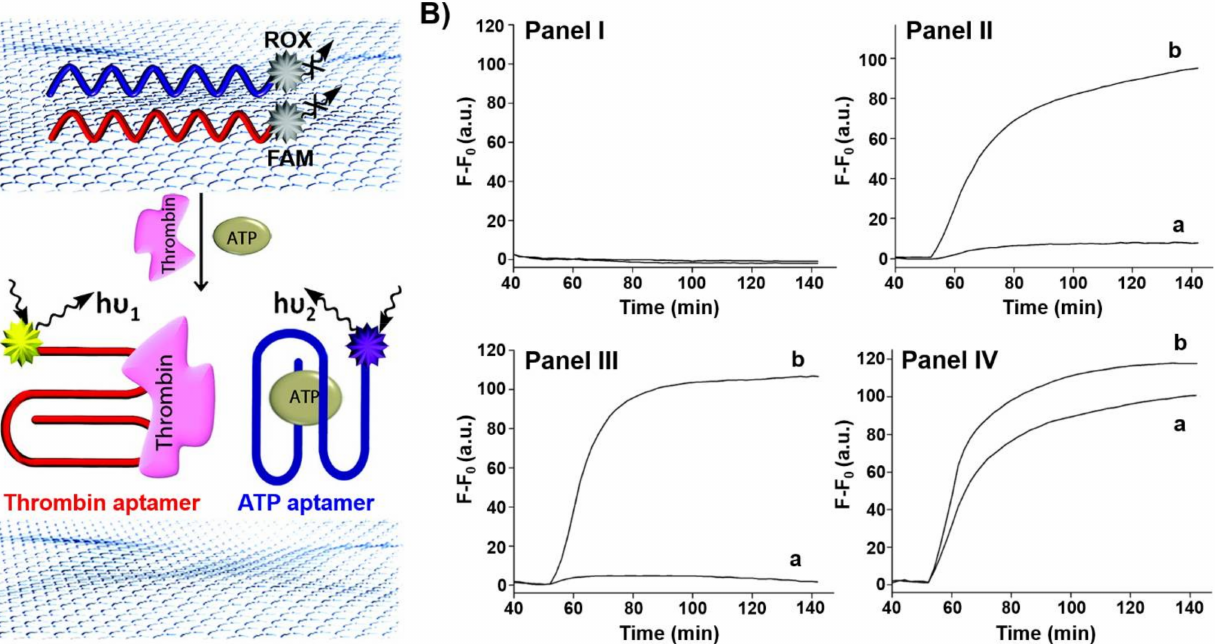
Figure 1. ( A ) Multiplex analysis of two ligands (thrombin, ATP) by 6-carboxyfluorescein (FAM)-functionalized thrombin aptamer and carboxy-X-rhodamine (ROX)-functionalized ATP aptamer using graphene oxide as an active support. The fluorescence of the respective fluorophores switches on after treatment with the ligands due to the desorption of the respective aptamer-ligand complexes from the graphene oxide. ( B ) Time-dependent fluorescent changes in the solution: Panel I—in the absence of ligands, Panel II—in the presence of thrombin, Panel III—in the presence of ATP, IV—in the presence of ATP and thrombin. a corresponds to the fluorescence of ROX and b of FAM. Reproduced with permission from ref. [90]. Copyright 2012 American Chemical Society. Arrows: the arrows correspond to typical excitation and emission